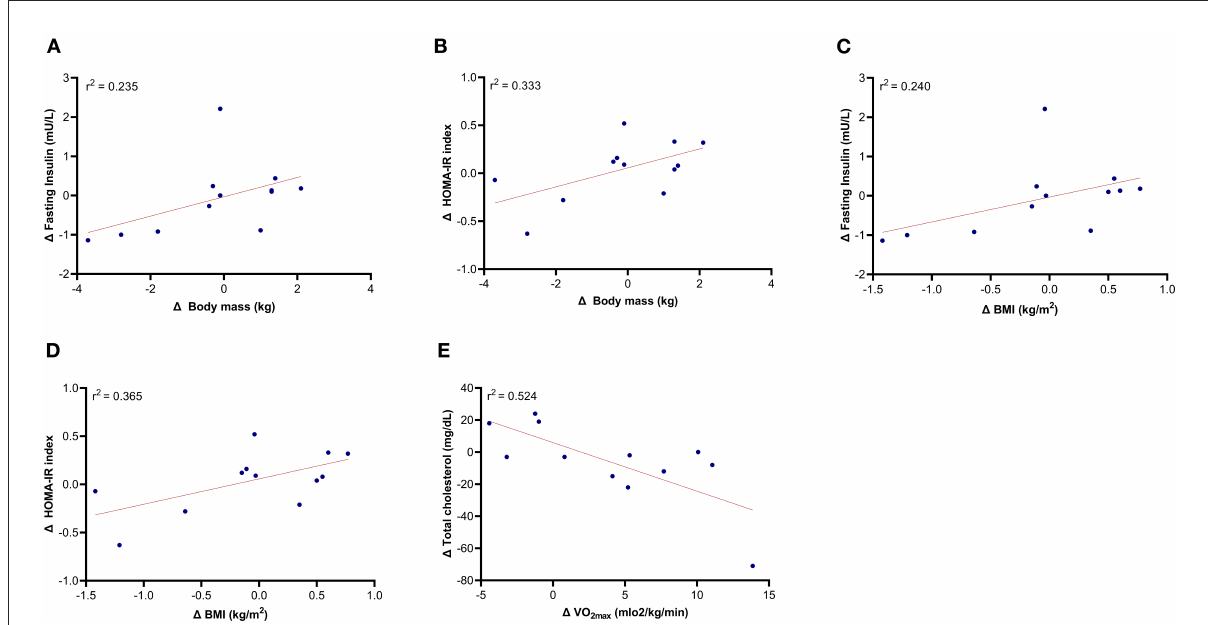
FIGURE3 Relationship of the changes in fasting insulin, HOMA-IR, total cholesterol with the changes in body composition and cardiorespiratory fitness (excluding control group). (A) 1 Body mass and 1 fasting insulin; (B) 1 Body mass and 1 HOMA-IR index; (C) 1 BMI and 1 fasting insulin; (D) 1 BMI and 1 HOMA-IR index; (E) 1 Vo2max and 1 Total